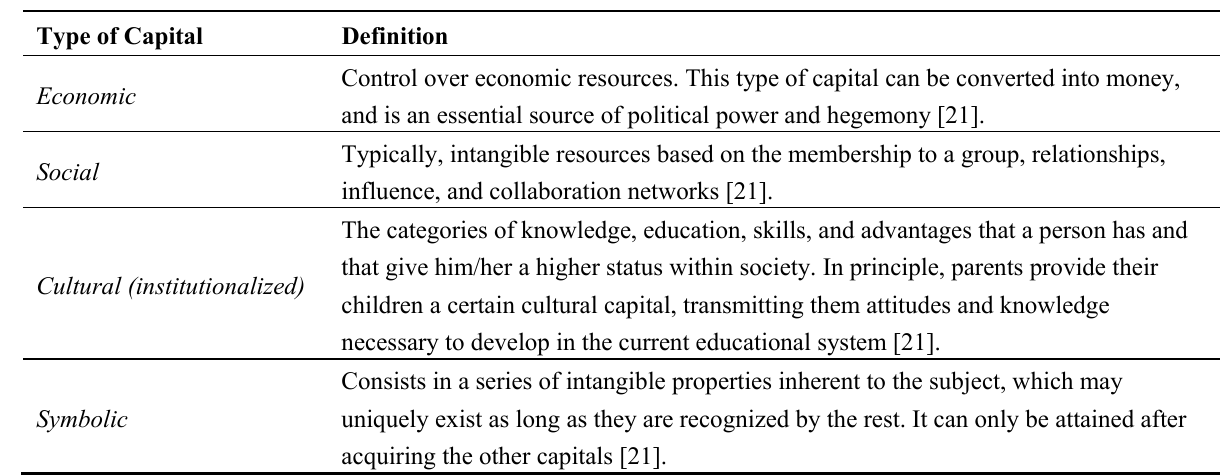
Table 1. Definitions and expressions of capital according to